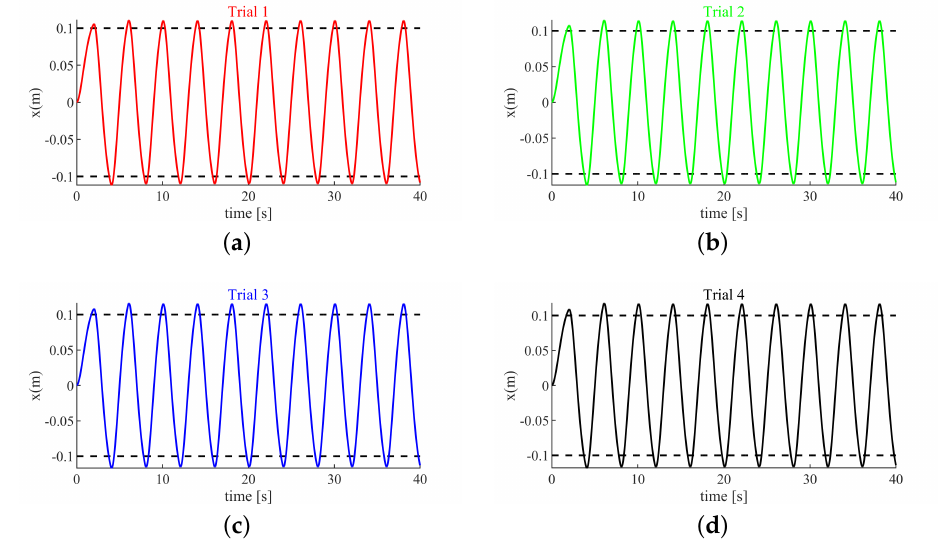
Figure 9. The end effector position value. ( a ) The end effector position value in Trial 1. ( b ) The end effector position value in Trial 2. ( c ) The end effector position value in Trial 3. ( d ) The end effector position value in Trial 4.